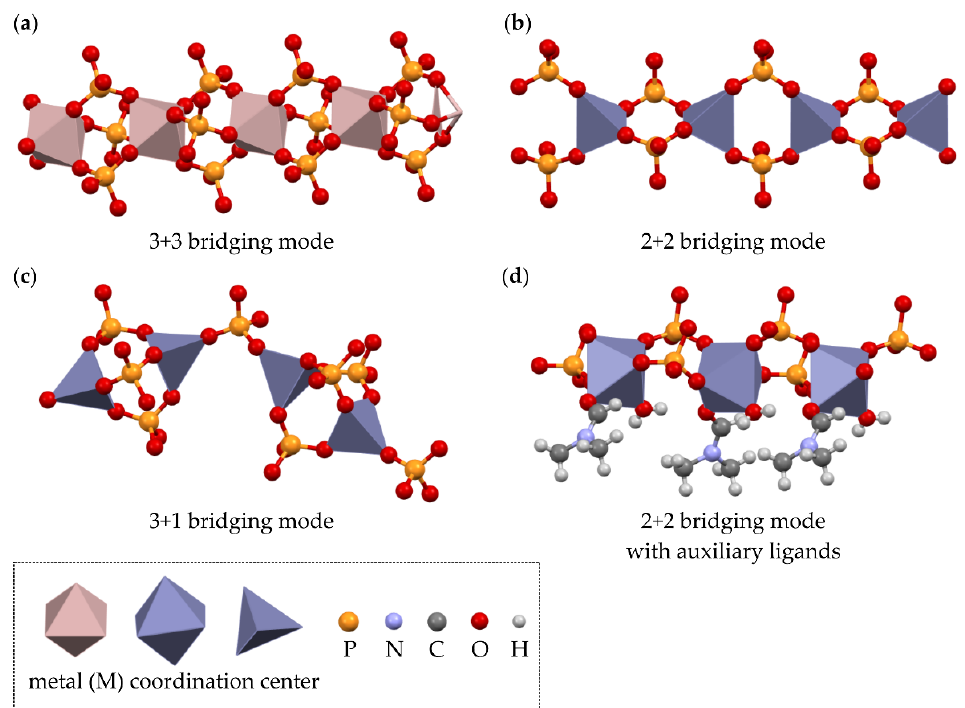
Figure 1. Different modes of metal center binding by (RO) 2 PO 2 − ligands occurring in polymeric metal diorganophosphates: ( a ) triple (RO) 2 PO 2 − bridges, ( b ) double (RO) 2 PO 2 − bridges, ( c ) alternating triple and single (RO) 2 PO 2 − bridges and ( d ) double (RO) 2 PO 2 − bridges with additional ligands. For clarity of presentation organic substituents R are omitted.